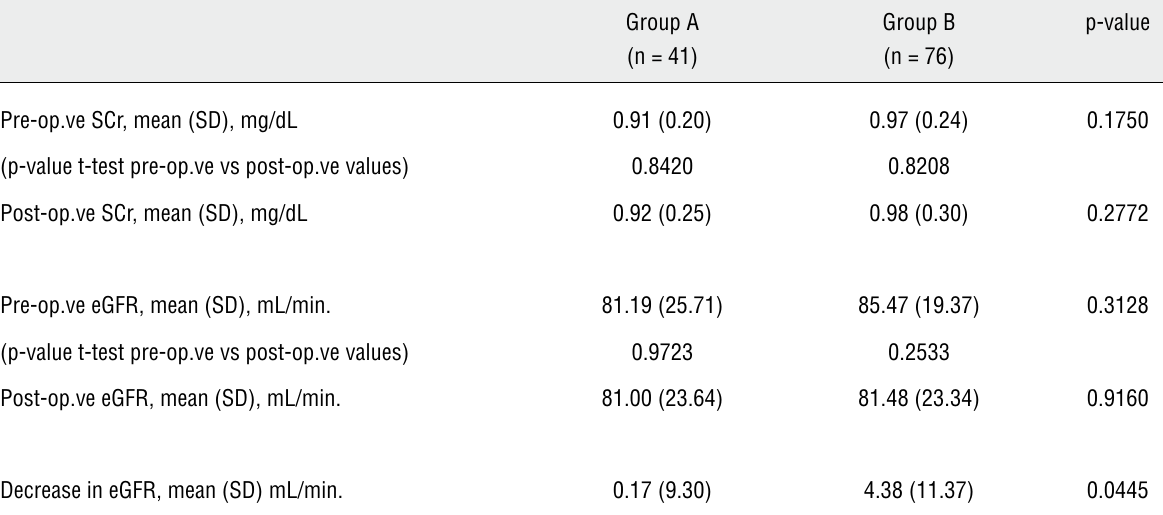
Table 2 - Pre-operative and Post-operative functional